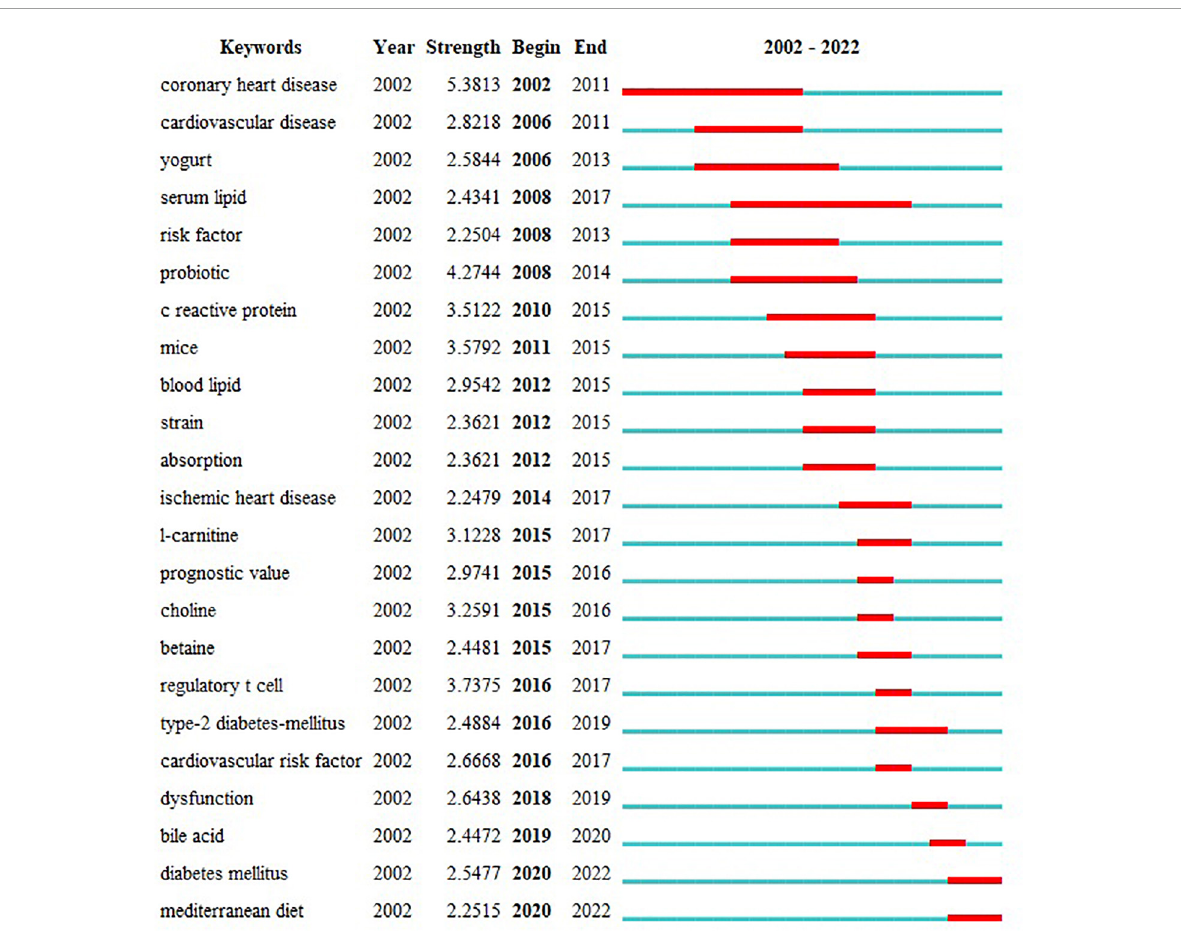
FIGURE7 Top 23 keywords with the strongest citation bursts. Begin and End represent the beginning and end years of keyword emergence respectively. Strength indicates the intensity of the cited change. Each red or blue bar represents the time interval, and a single bar is equal to one year. The red bar especially represents citation burst.